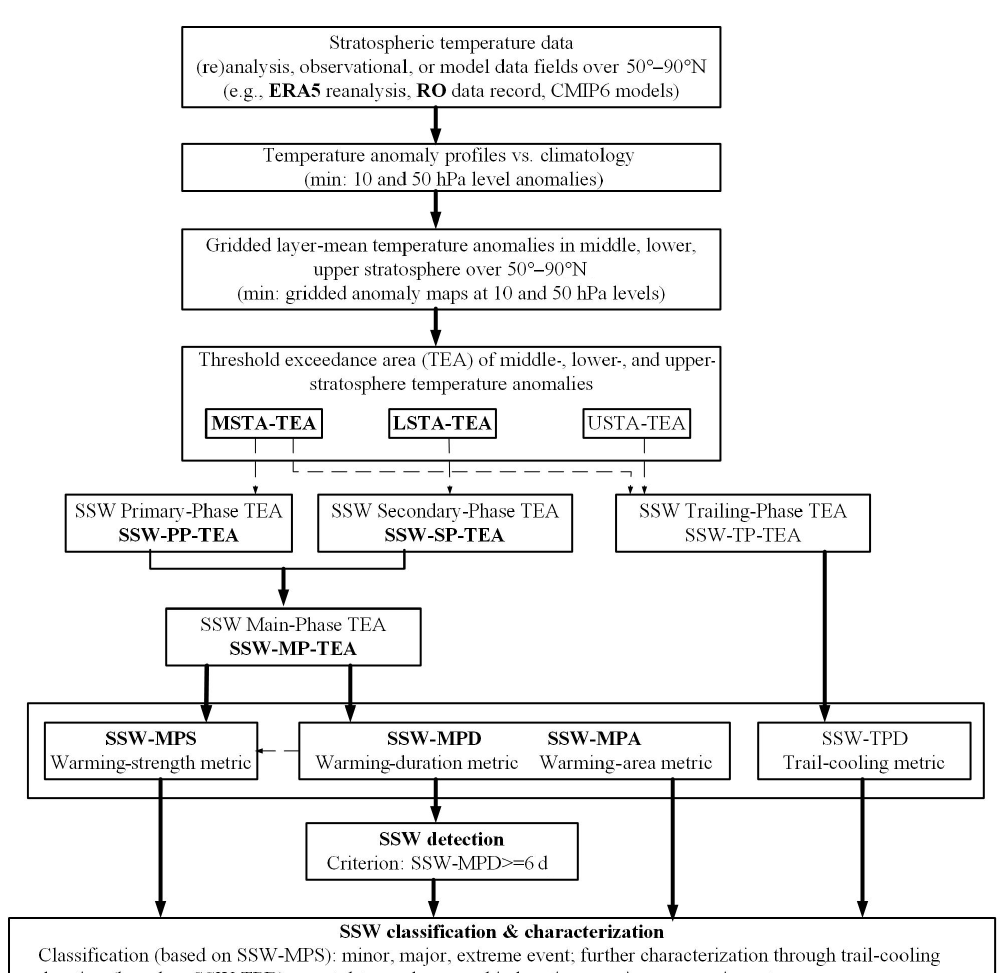
Figure 2. Schematic overview of the new SSW detection and monitoring approach and its main algorithmic steps, from the temperature input data (top) to the final SSW metrics (in particular SSW-MPD, SSW-MPA, SSW-MPS; see Table 2, lines 1–3) and their use for detection, classification, and further event characterization (bottom). For implementation details, see Tables 1 and 2 and the description in Sect.